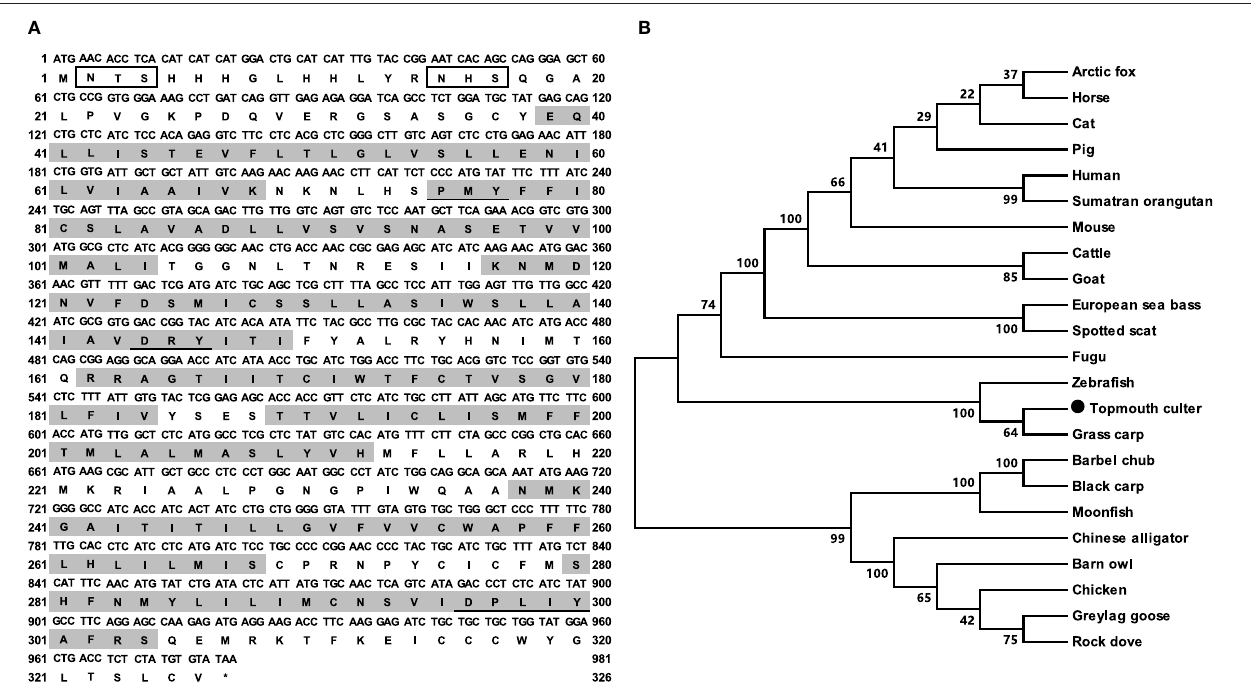
FIGURE 1 | Nucleotide and deduced amino acid sequences and phylogenetic tree of caMC4R. (A) Nucleotide and deduced amino acid sequences of caMC4R. Positions of nucleotide and amino acid sequences are indicated on both sides. Shaded boxes denote putative TMD1-7. Potential phosphorylation sites are present in oval frame. Underline show PMY, DRY, DPxxY motifs. Open boxes denote the consensus sequence for N -linked glycosylation sites. Asterisk (*) indicates stop codon. (B) Phylogenetic tree of MC4R proteins. The tree was constructed by the neighbor-joining (NJ) method. Numbers at nodes indicate the bootstrap value, as percentages, obtained for 1,000 replicates. Black dot shows caMC4R. MC4Rs: Culter alburnus (topmouth culter, MT163518), Scatophagus argus (spotted scat, KU760724.1), Dicentrarchus labrax (European sea bass, CBN82190.1), Lepisosteus oculatus (spotted gar, XP_006634516.1), Danio rerio (zebrafish, NP_775385.1), Vulpes lagopus (arctic fox, ACN55093.1), Ctenopharyngodon idella (grass carp, AOZ60534.1), Paralichthys olivaceus (Japanese flounder, ADP09415.1), Squaliobarbus curriculus (barbel chub, ADV40875.1), Takifugu rubripes (fugu, NP_001027732.1), Mylopharyngodon piceus (black carp, ADV40871.1), Tyto alba (barn owl, ATN96237.1), Columba livia (rock dove, XP_021153678.1), Bos taurus (cattle, NP_776535.1), Alligator sinensis (Chinese alligator, XP_006025279.1), Anser anser (greylag goose, ABF19809.1), Pongo abelii (Sumatran orangutan, XP_002828309.1), Equus caballus (horse, XP_001489706.1), Felis catus (cat,